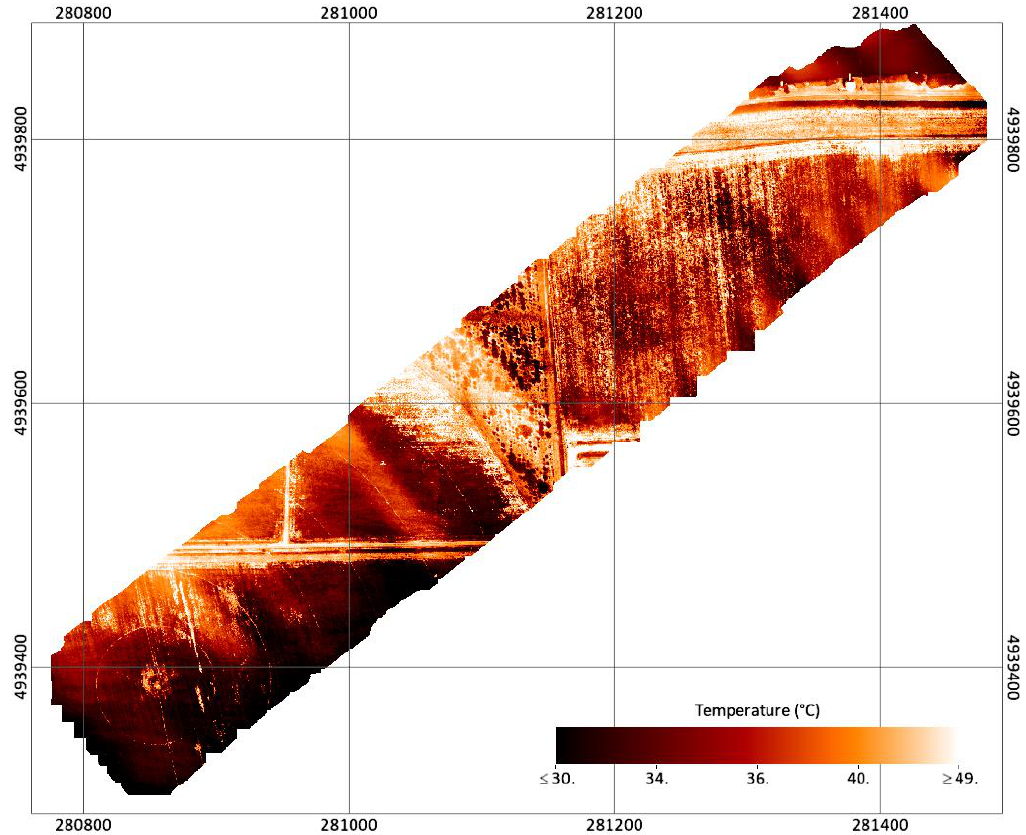
Figure 4. Thermal orthomosaic acquired on 19 July 2019. Reported temperatures are derived with a constant 0.95 emissivity. Grid coordinates are UTM-ETRS89 Zone 33T.